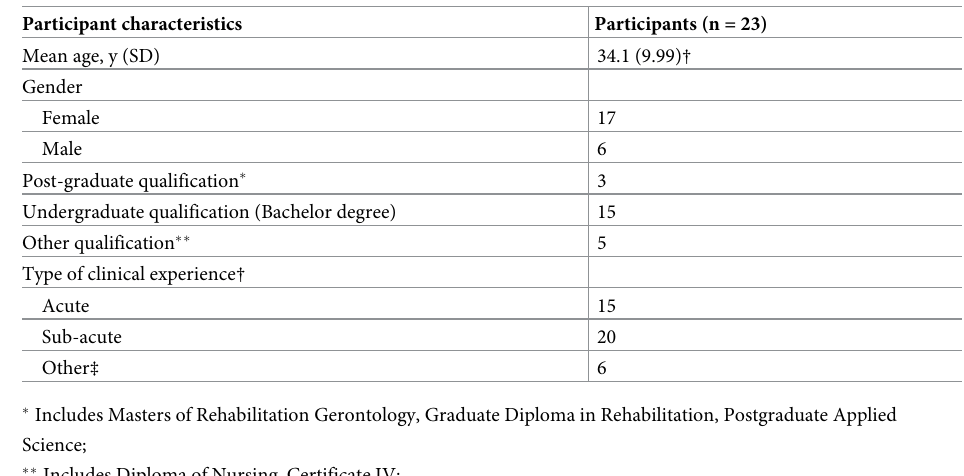
Table 2. Health professional participant